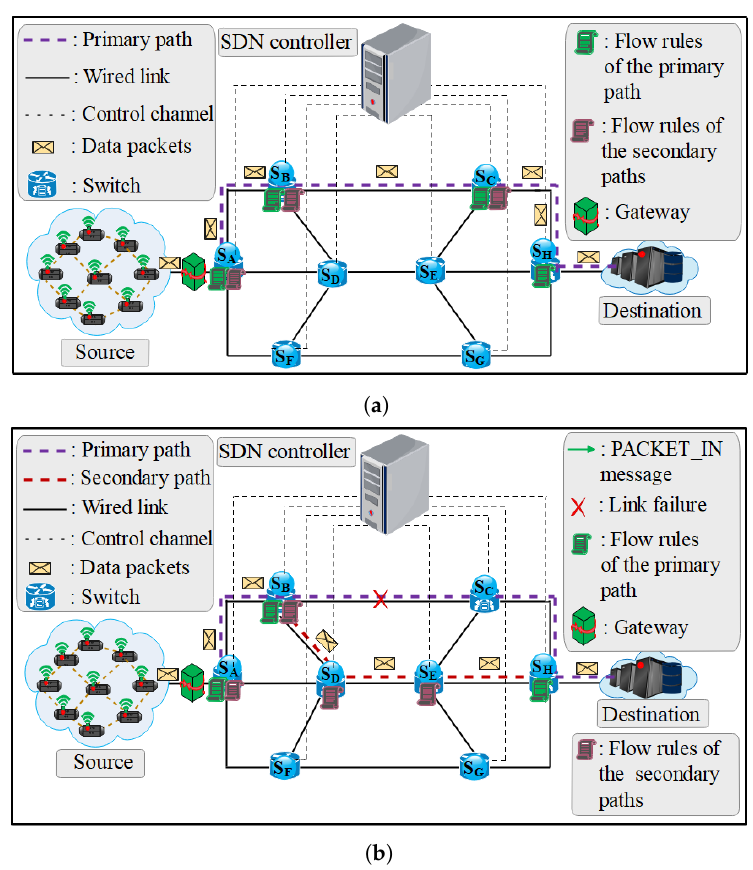
Figure 2. Example of Path Protection (PP) application for the SDN platform. ( a ) Before an intermedi- ate link S B → S C failure. ( b ) After an intermediate link S B → S C